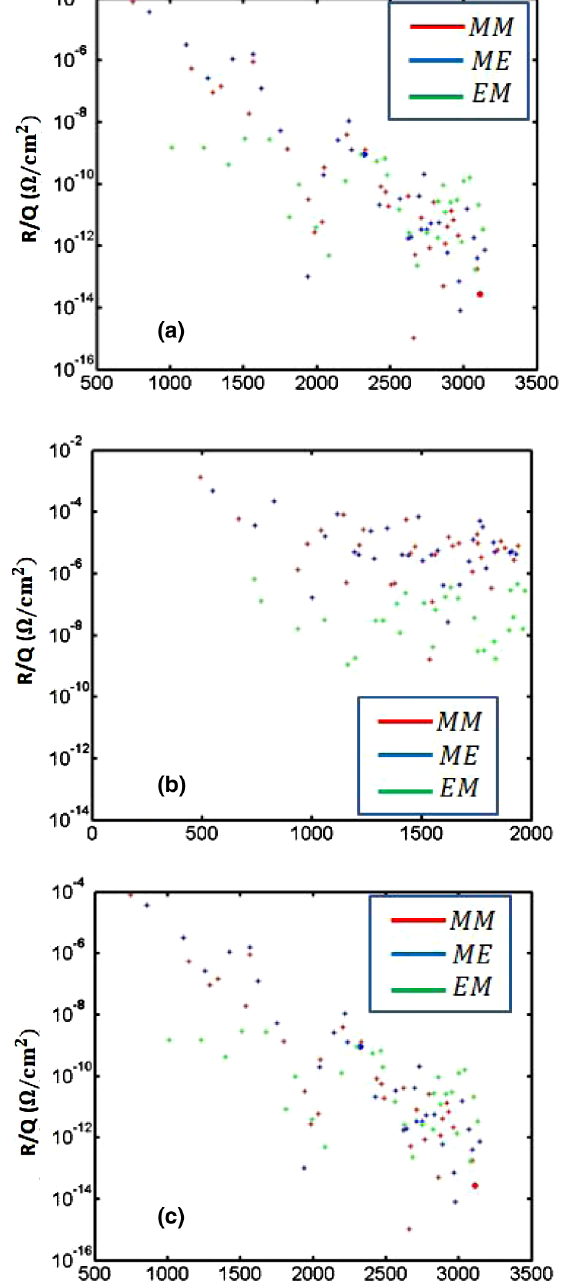
FIG. 22. Transverse R/Q for the dipole and quadrupole modes in the (a) SSR-A, (b) SSR-B, and (c) SSR-C,